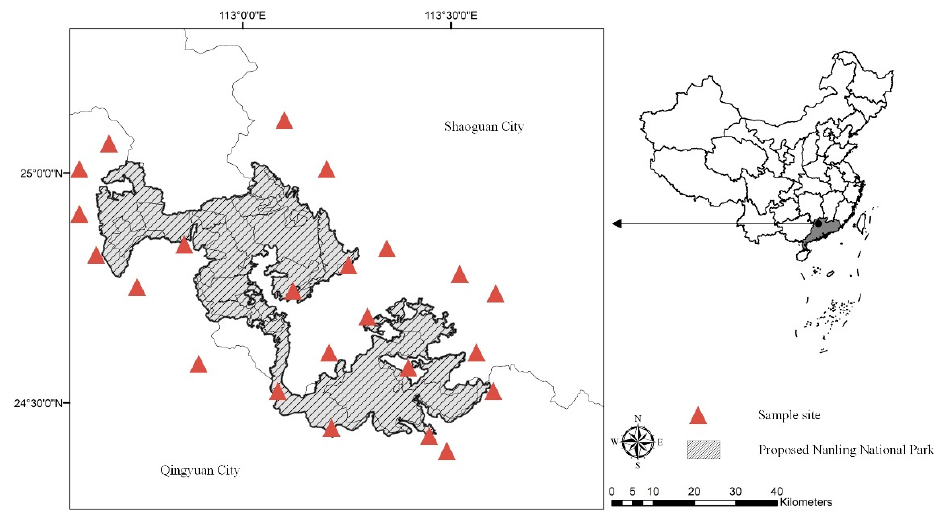
Figure 1. Proposed Nanling National Park study area (the area for the proposed Nanling National Park is still under discussion, and the map is only the initial proposed scope). Table 1. Description of measurement